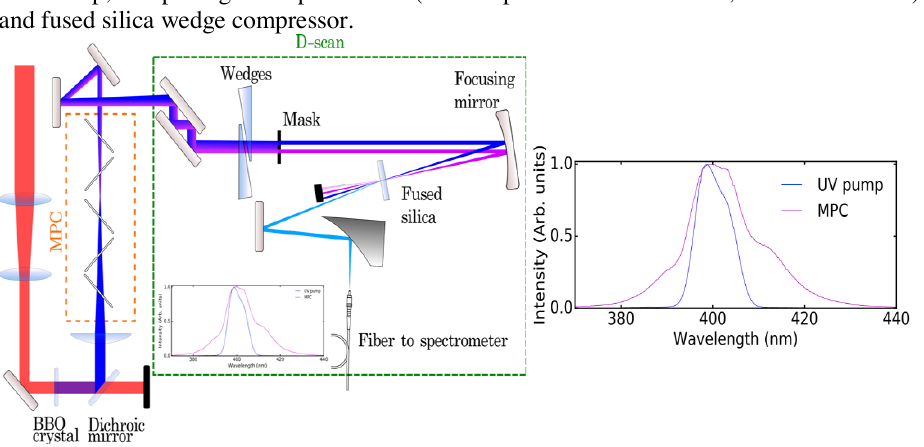
Fig. 1. (Left) Setup for generating multiplate continuum (MPC) at 400 nm, with temporal compression using chirped mirrors and temporal characterization by dual self-diffraction d-scan. (Right) uv input and MPC output spectra.